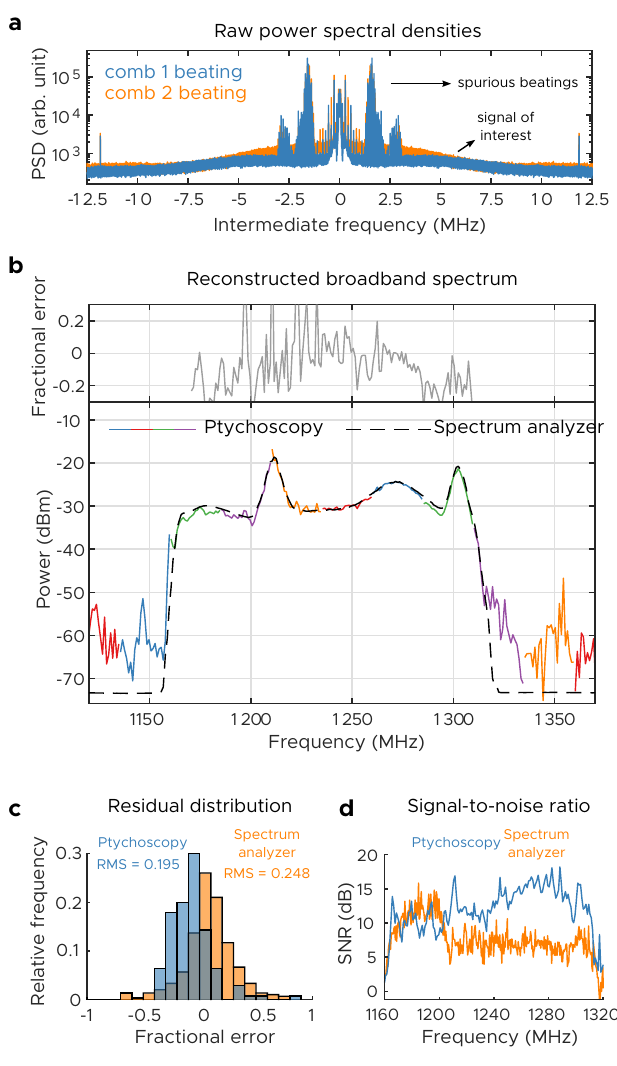
Fig. 6 Broaband microwave ptychoscopic experiment. a Raw power spectral densities of the recorded signals. b Spectral reconstruction by ptychoscopy and true spectrum. The multi-color curve is the reconstruction where each color corresponds to a different comb line. The dashed line represents the ground truth, as measured on an RF spectrum analyzer (averaged). c Comparison of the distribution of residuals between the ptychoscopic measurement (over the valid range) and the spectrum analyzer measurement when the measurements are taken with the same RBW and measurement time. d Comparison of the two signal-to-noise ratios (SNRs). The ptychoscopic measurement is better on account of the non-ergodicity of the incoherent